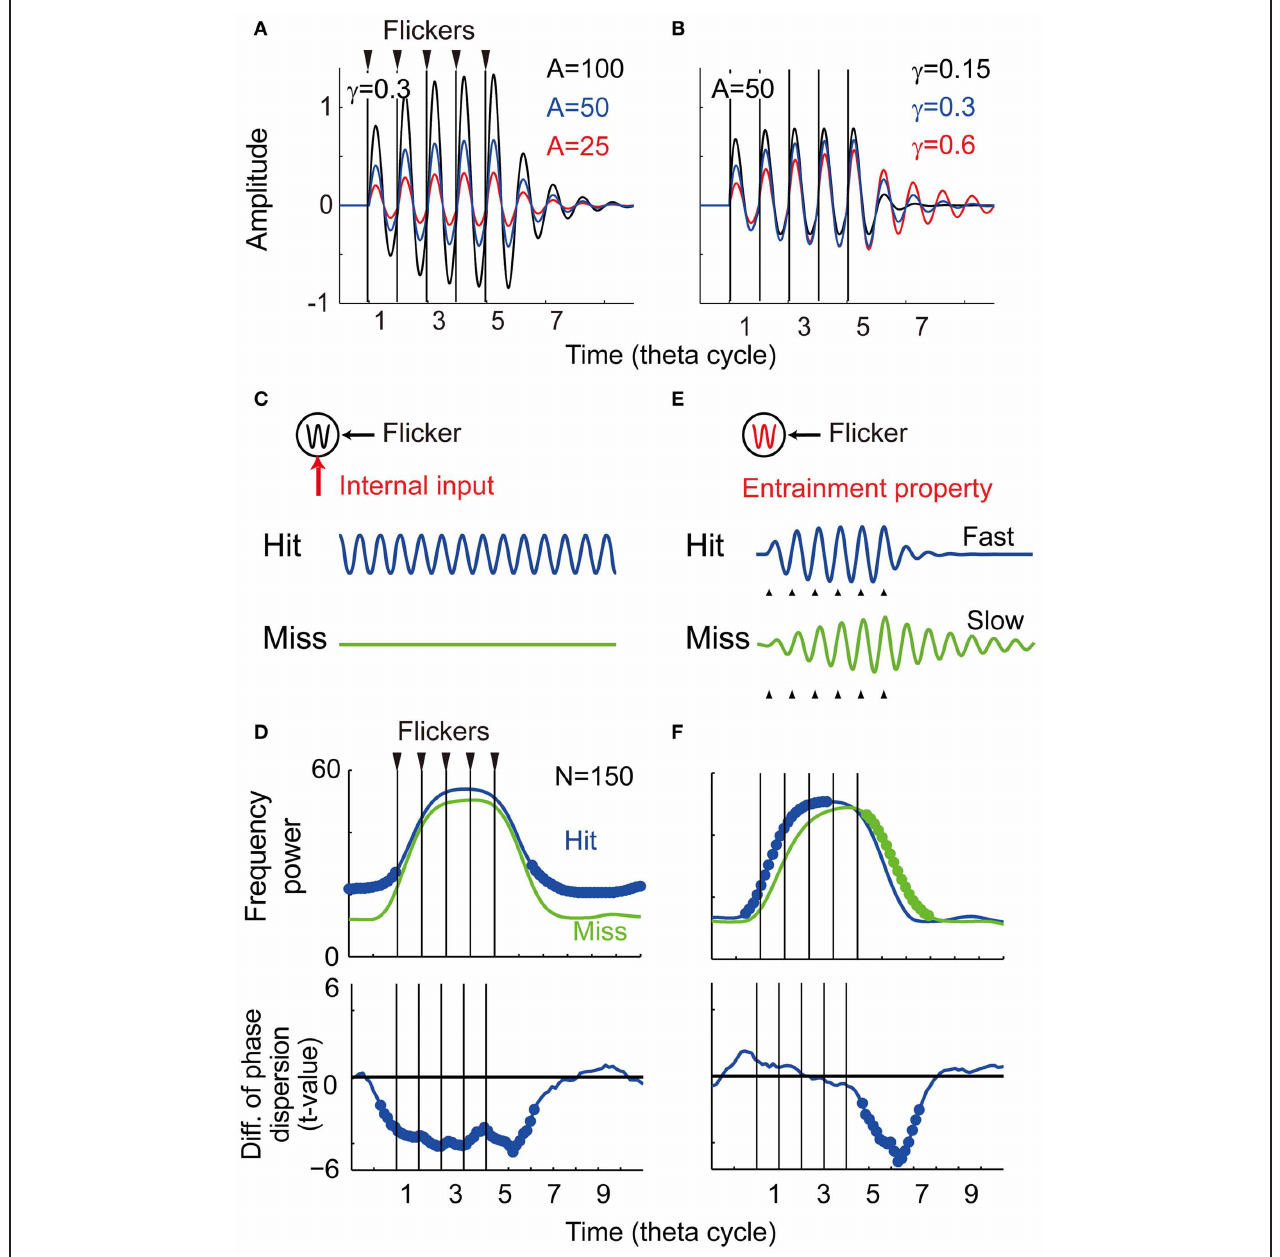
FIGURE 7 | Computational simulation. (A) Temporal evolution of potentials with different intensity of the input ( α = 25, 50, and 100). (B) Temporal evolution of potentials with different damping coefficient of oscillator ( γ = 0 . 15, 0.3, and 0.6). (C) The first model assuming a memo-dependent oscillatory input in which phase is independent to the phase of the flicker. (D) Simulation results of the first model showing averaged spectral power